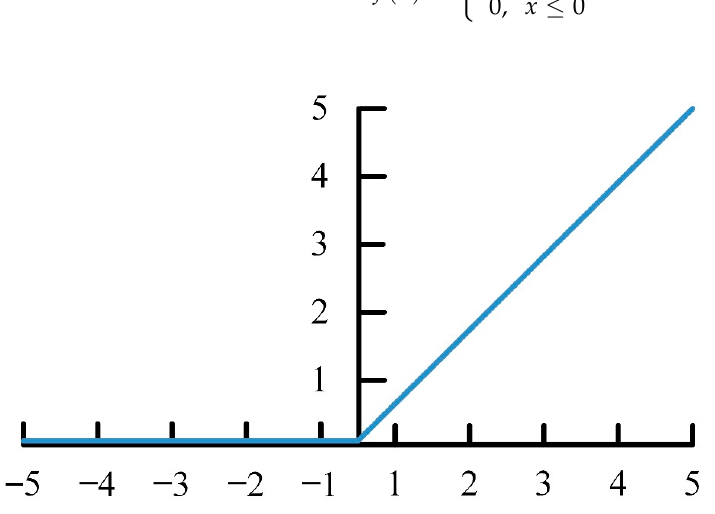
Figure 15. Activation function for ReLU.